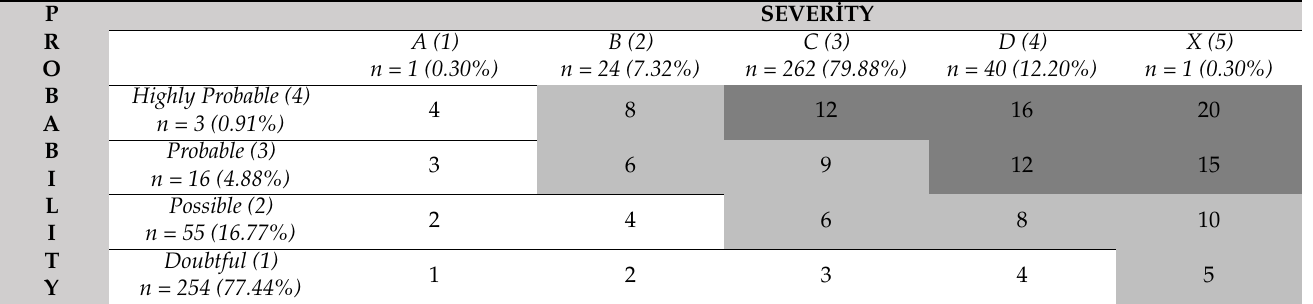
Table 3. Distribution of potential drug–drug interactions detected by probability and severity.